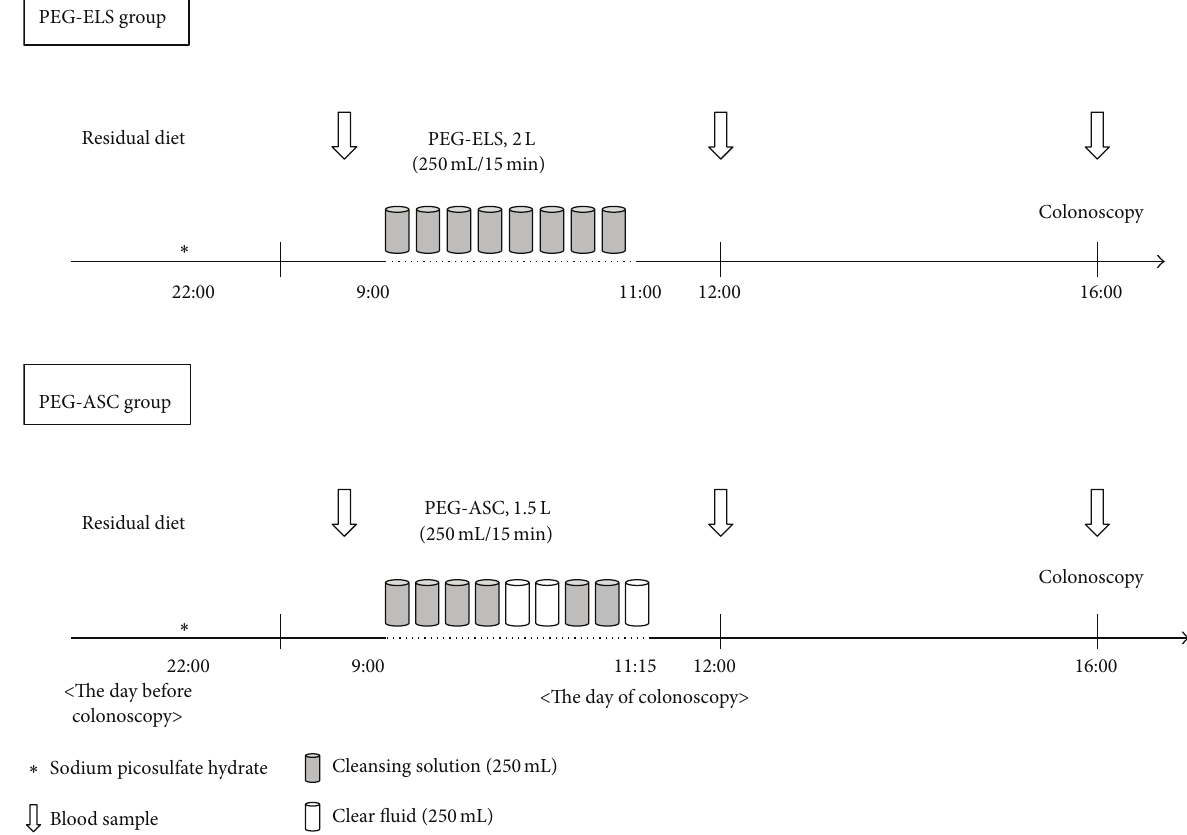
Figure 1: The study schedule. PEG-ELS, polyethylene glycol electrolyte lavage solution. PEG-ASC, polyethylene glycol electrolyte lavage solution containing ascorbic